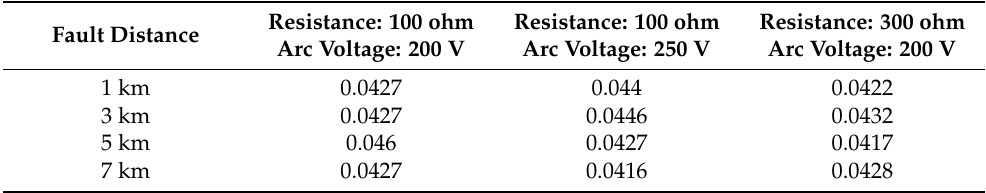
Table 3. Mean value of low frequency singular value under different fault conditions.